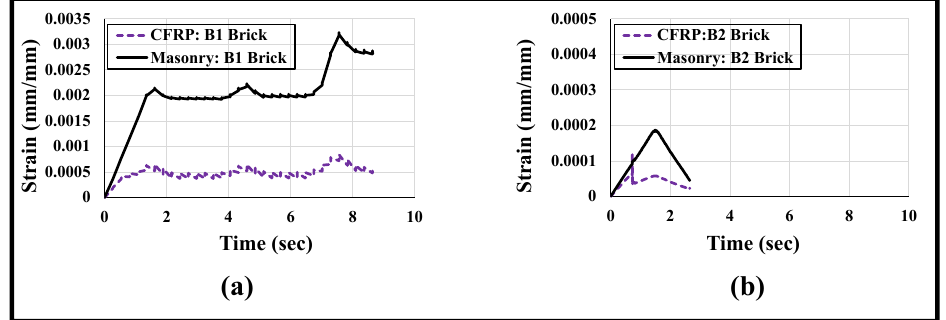
Figure 18. Strain history curve (numerically predicted) plotted at mid-height on the surface of CFRP and masonry wallettes constructed of different brick types, ( a ) B1 and ( b ) B2, tested under cyclic loading.